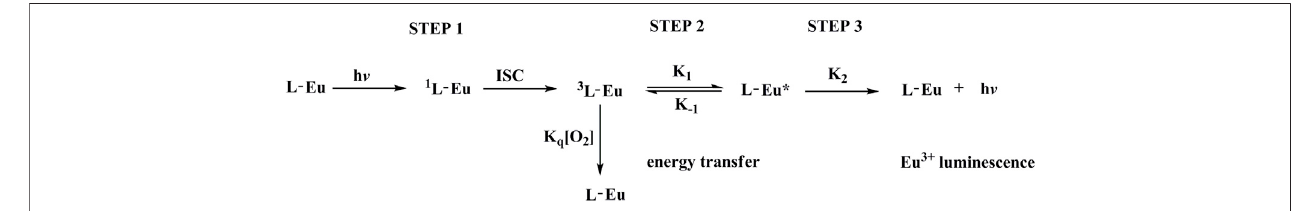
FIGURE 10 | Key photophysical processes of sensitized Eu 3+ luminescence.